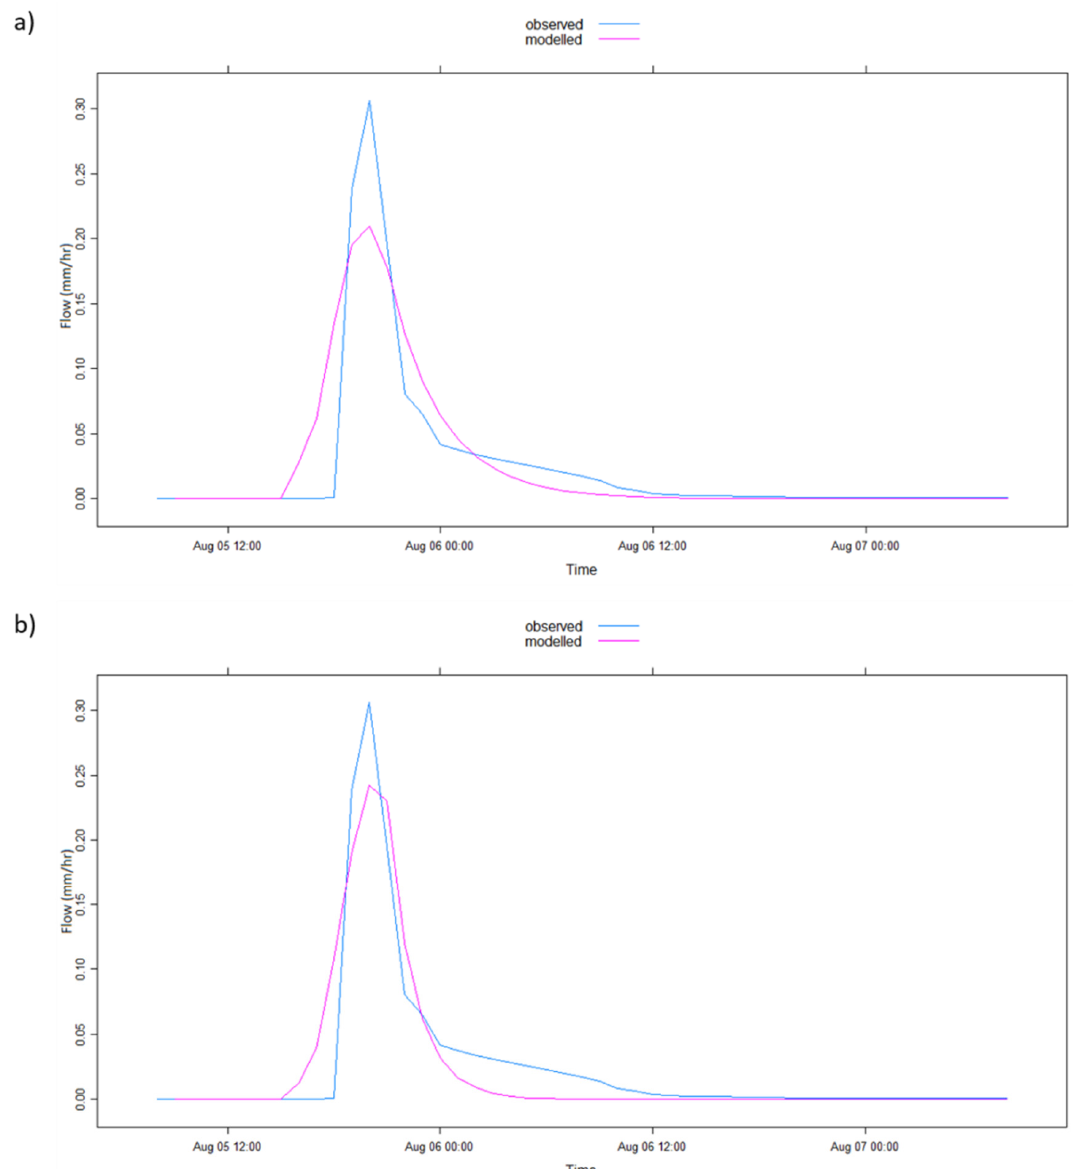
Figure 9. IHACRES model simulation results with ( a ) rsq_daily and ( b ) rsq_hourly objective functions for the 2006 flood events.